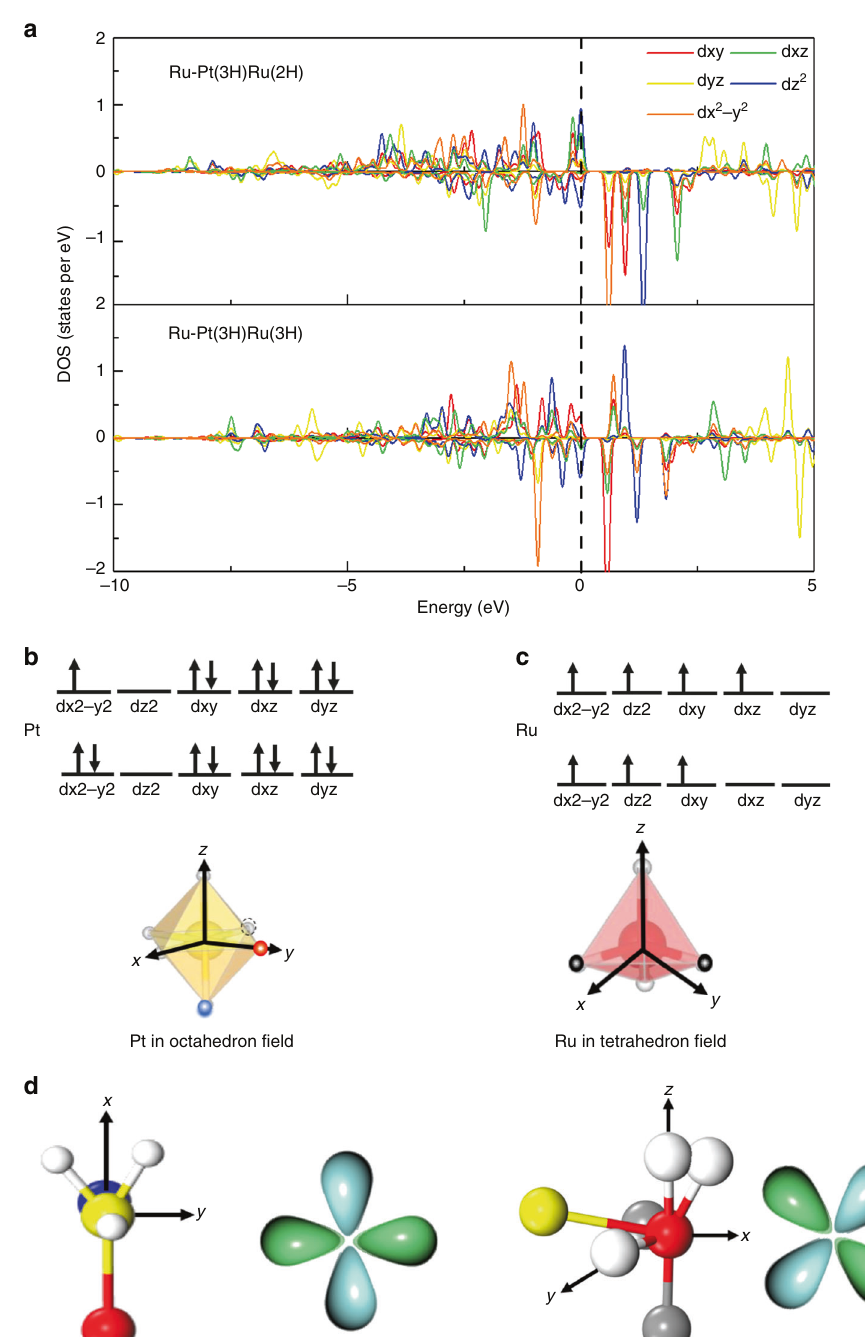
Fig. 6 Electronic structures and crystal fi eld of the Ru atom for the last two steps. a The Projected DOS of Ru atom for Pt(3H)Ru(2H) and Pt(3H)Ru(3H). b Schematic of crystal fi eld of Ru. c The dyz orbital of Ru of Pt(3H)Ru(2H) and the dyz orbital of Ru of Pt(3H)Ru(3H). Here, Pt(nH)Ru(mH) represents n H atoms adsorbed on Pt and m H atoms on Ru. Red, yellow, blue and gray ball represent the Ru, Pt, N and C atoms,